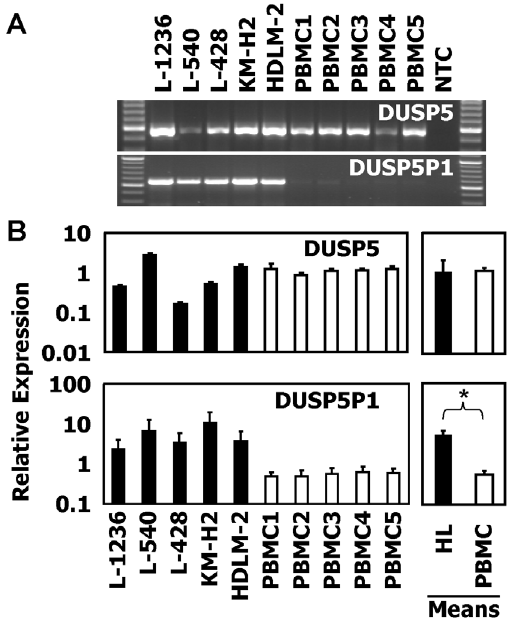
Figure 4. Expression of DUSP5P1 and DUSP5 in HL cell lines. (A) Presented are results from a RT-PCR with primers with specificity for DUSP5 and DUSP5P1. cDNA from HL cell lines and normal PBMC was used as template for PCR. NTC: no template control. (B) Presented are results from a quantitative RT-PCR (means and standard deviations from 3 experiments) with primers with specificity for DUSP5 and DUSP5P1. cDNA from HL cell lines and normal PBMC was used as template for PCR. For calculation of relative expression values, GAPDH was used as housekeeping control and the mean D ct value was set as 1. In addition to the results from individual cell lines, the mean values from HL cell lines and PBMC are presented. Asterisk indicate statistical significance (p , 0.05; Student’s